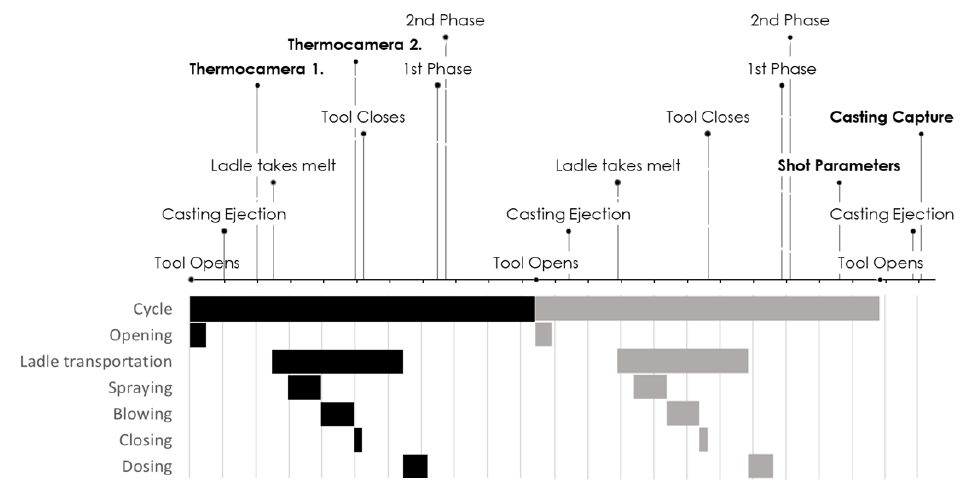
Figure 1. The first stages of the experimental procedure timeline.